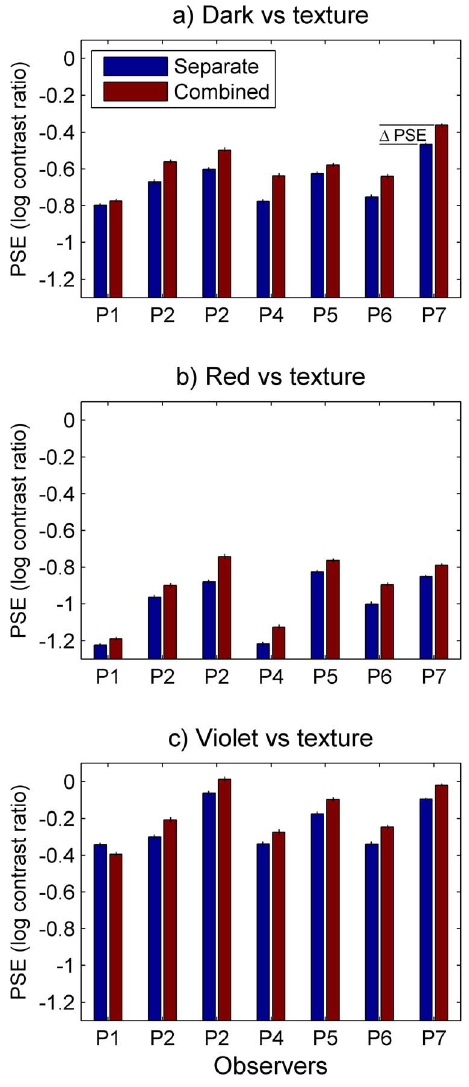
Fig. 3. PSE estimates. PSE estimates are shown for seven observers for all three cue combinations and the two presentation conditions: a) dark vs. texture; b) red vs. texture; c) violet vs. texture. Blue bars show PSEs for the Separate condition; red Combined. Error bars show bootstrapped standard error estimates. Negative PSE’s indicate that more texture contrast is required at the PSE but positive shifts in PSE between conditions indicate that less texture contrast is required in the Combined compared to Separate